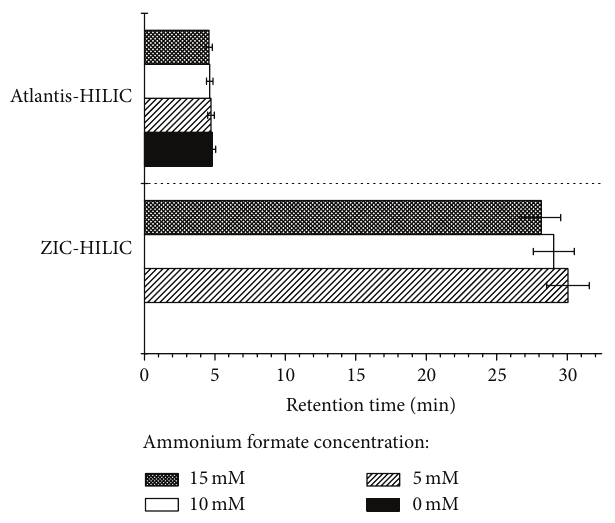
Figure 2: The retention time of rutin at different concentration of ammonium formate (95% ACN v/v pH